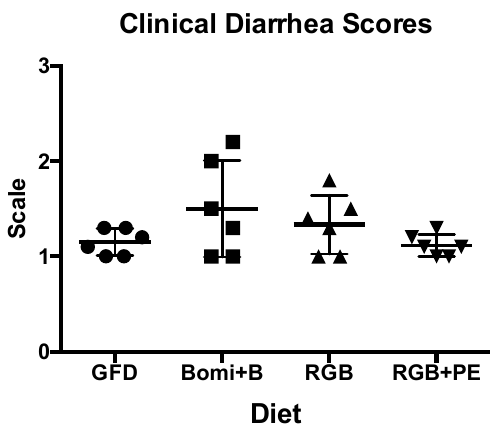
Figure 2. Clinical diarrhea scores generated with GS macaques fed gluten ‐ modified diets (GFD, Bomi + B, RGB and RGB + PE) are shown.